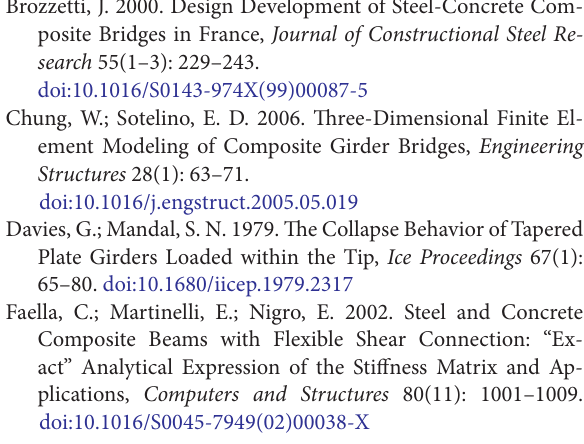
fluence appears closely linked to the class combination of the compressed flange and the web of the girder. The local buckling mostly occurs when the web is of a higher class (less resistant) than the compressed flange. In this case, if the local buckling is not taken into account, the rule of 10% moment redistribution proposed by the prEN 2003 – Eurocode 4 becomes inadequate especially for symmetrical loading case. If local buckling is taken into account, the calculation of the moment redistribution coefficient after buckling is the one obtained considering specific construc- tive measures (web-stiffeners) to avoid local buckling (Fig. 14a). Without stiffeners, no redistribution is allowed for these cross-section classes. kaloud and Zörnerova